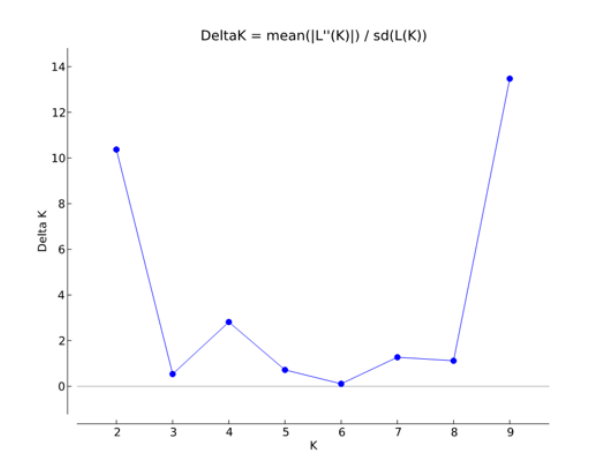
Figure 1. Plot of deltaK values from the Bayesian genetic structure analyses of 165 plum